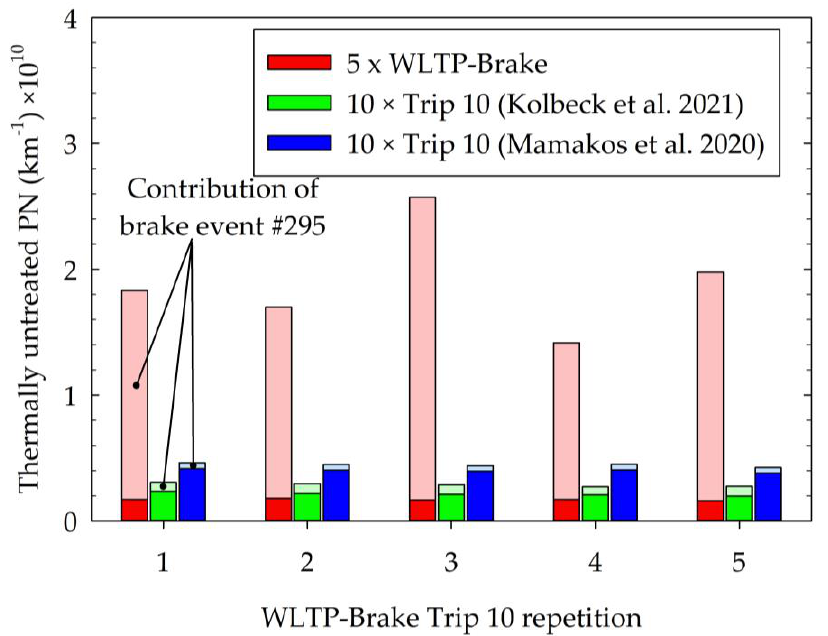
Figure 9. Evolution of thermally untreated PN emissions over successive repetitions of trip 10 of the WLTP-Brake following conditioning of fresh pads using 5 repetitions of the whole WLTP (red-bars) or 10 repetitions of trip-10 of the WLTP-Brake cycle (green and blue bars). The tests from [19] were performed at the same facility over the same period using the same UCPC. The tests from [17] were performed on a smaller tunnel using a 10 nm full-flow CPC. The contribution of emissions over the 295th brake event where the thermally stable nanoparticles were observed is indicated with light colors.